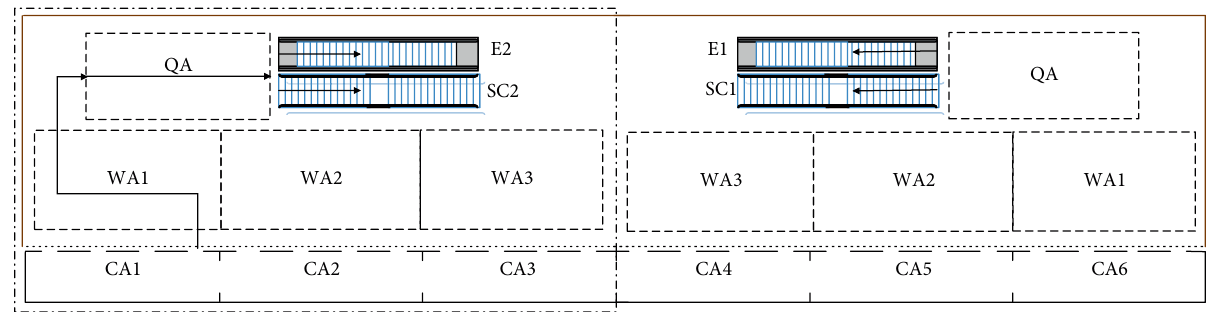
Figure 8: Area division for P_CPL. The queuing area, the walking area, and the carriage marked as QA, WA, and CA respectively. WA is divided into three parts corresponding to CAs. A representative of the walking path on P_CPL starting from one of the train doors is shown in solid black arrows.